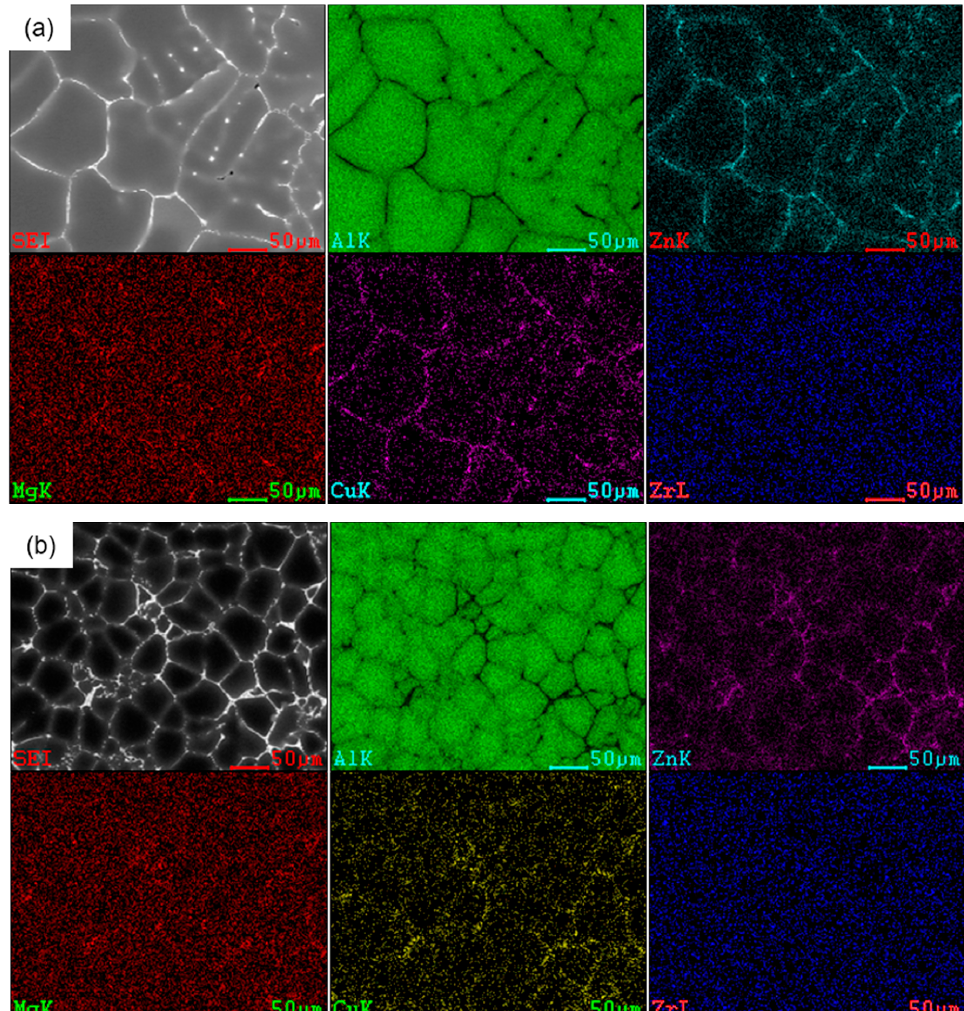
Figure 5. EDS mapping images analysis of the Al-Zn-Mg-Cu-Zr at 640 °C: ( a ) without treatment, ( b ) with IC-AEMS treatment.